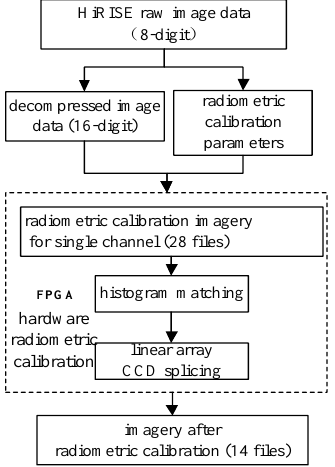
Figure 2. Radiometric calibration process for HiRISE imagery based on